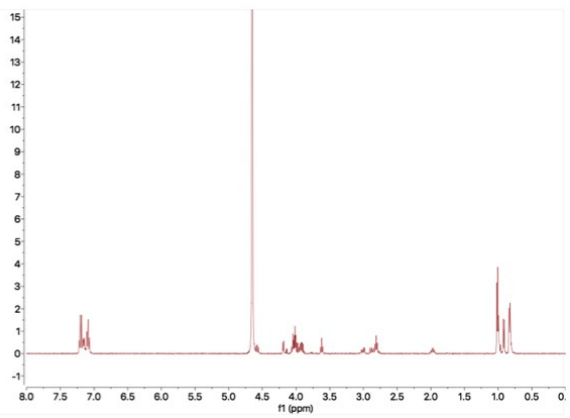
Figure 7. 1 H-NMR spectrum of CSP7 aggregates after 12 h shaking on an orbital shaker at 25 °C.